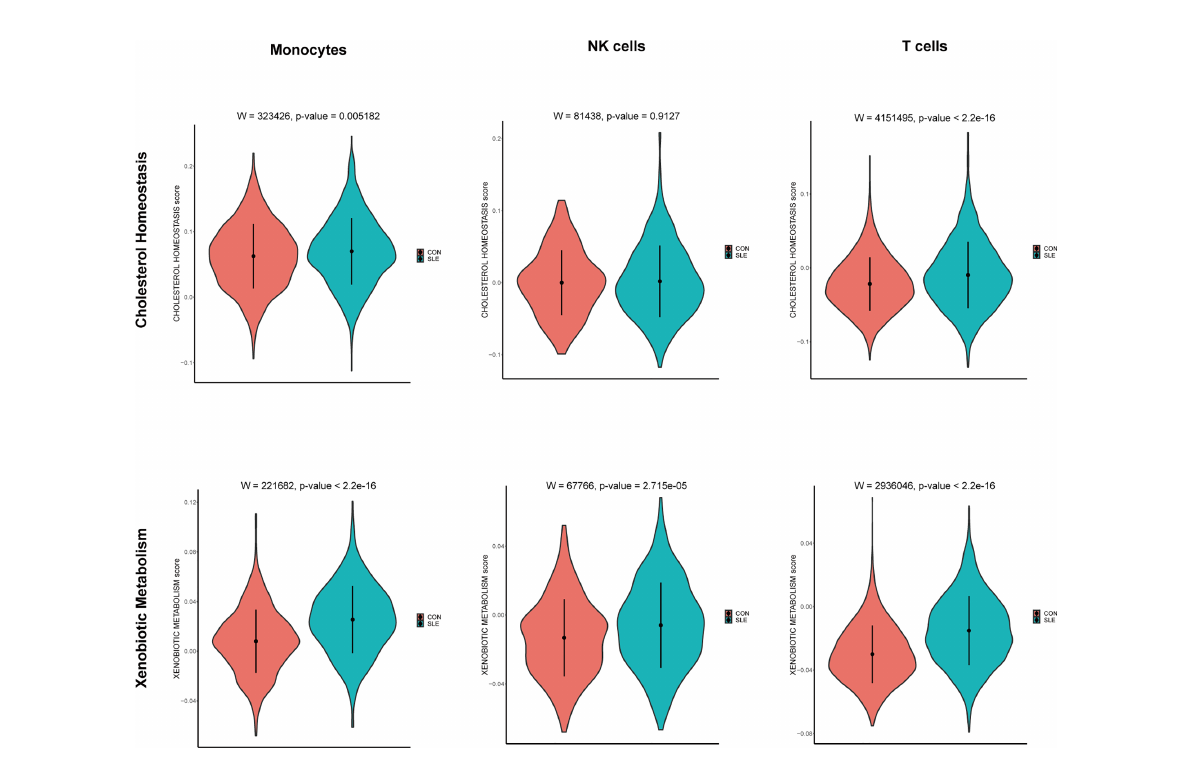
FIGURE 12 Violin plots of the cholesterol homeostasis and xenobiotic metabolism levels in monocytes, NK cells, and T cells of controls and SLE; Comparison was conducted by Wilcoxon rank-sum